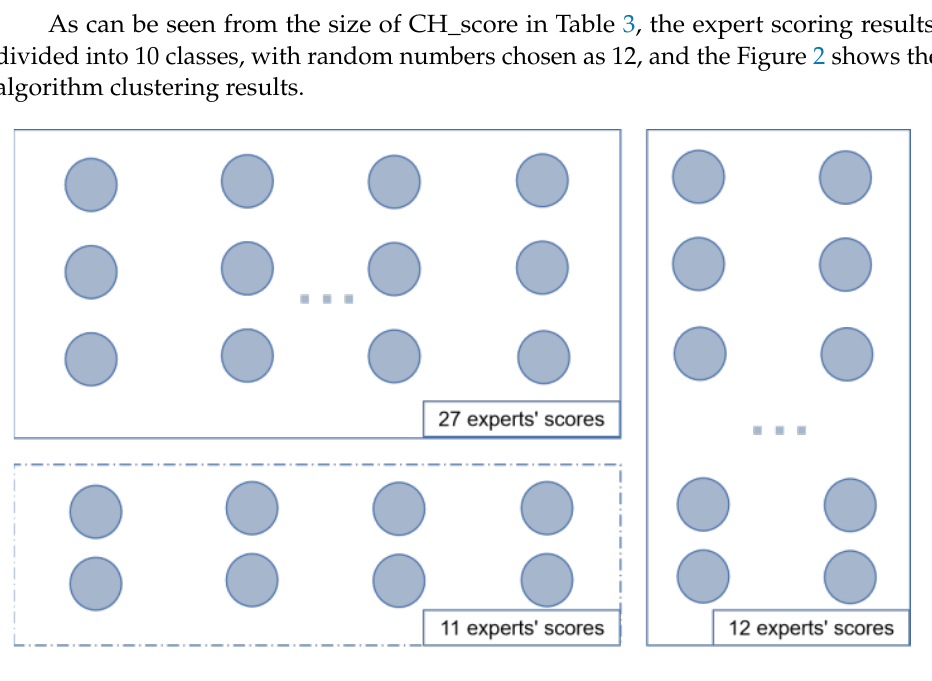
Table 3. Basis for selection of SC algorithm parameters.